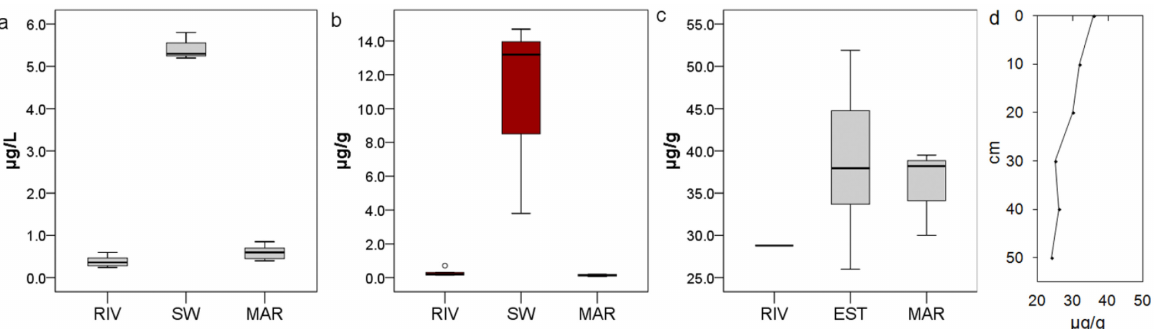
Figure 10. Spatial variation of Cu in ( a ) the dissolved phase; ( b ) the suspended particulates and ( c ) surface sediments of the riverine (RIV), the salt-wedge (SW) and the marine (MAR) sector of the Louros system; ( d ) vertical distribution of labile Cu extracted by 0.5 N HCl in a core obtained from the